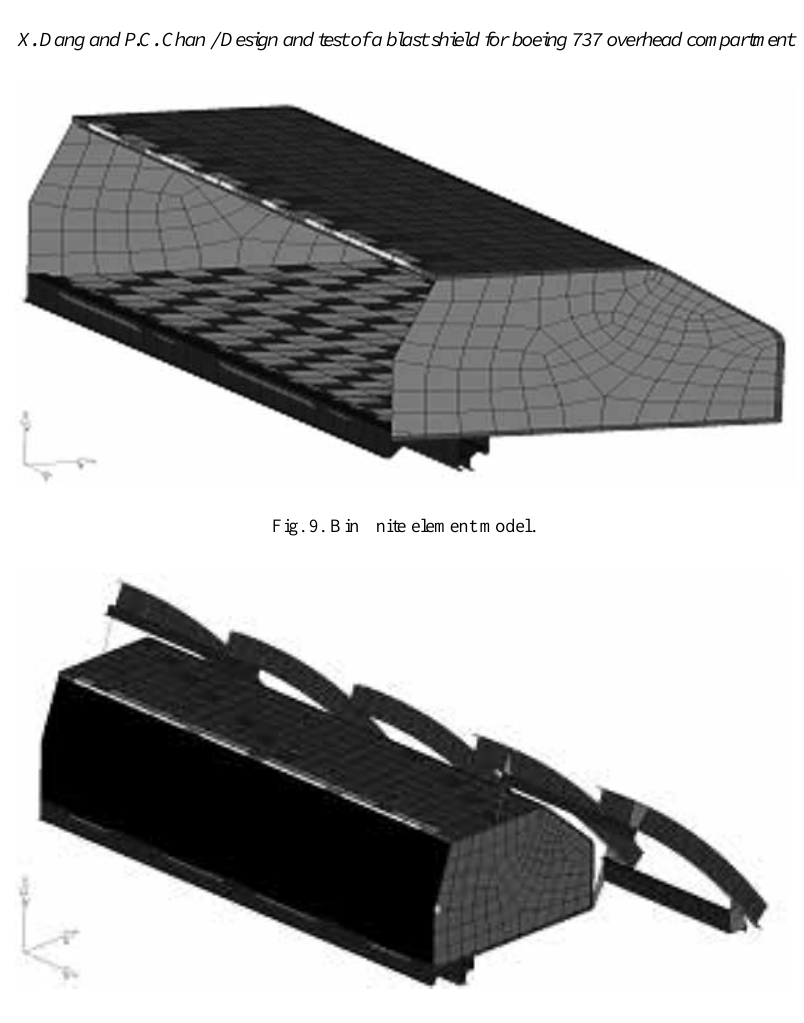
Fig. 10. Front view of the bin attachments to frames.